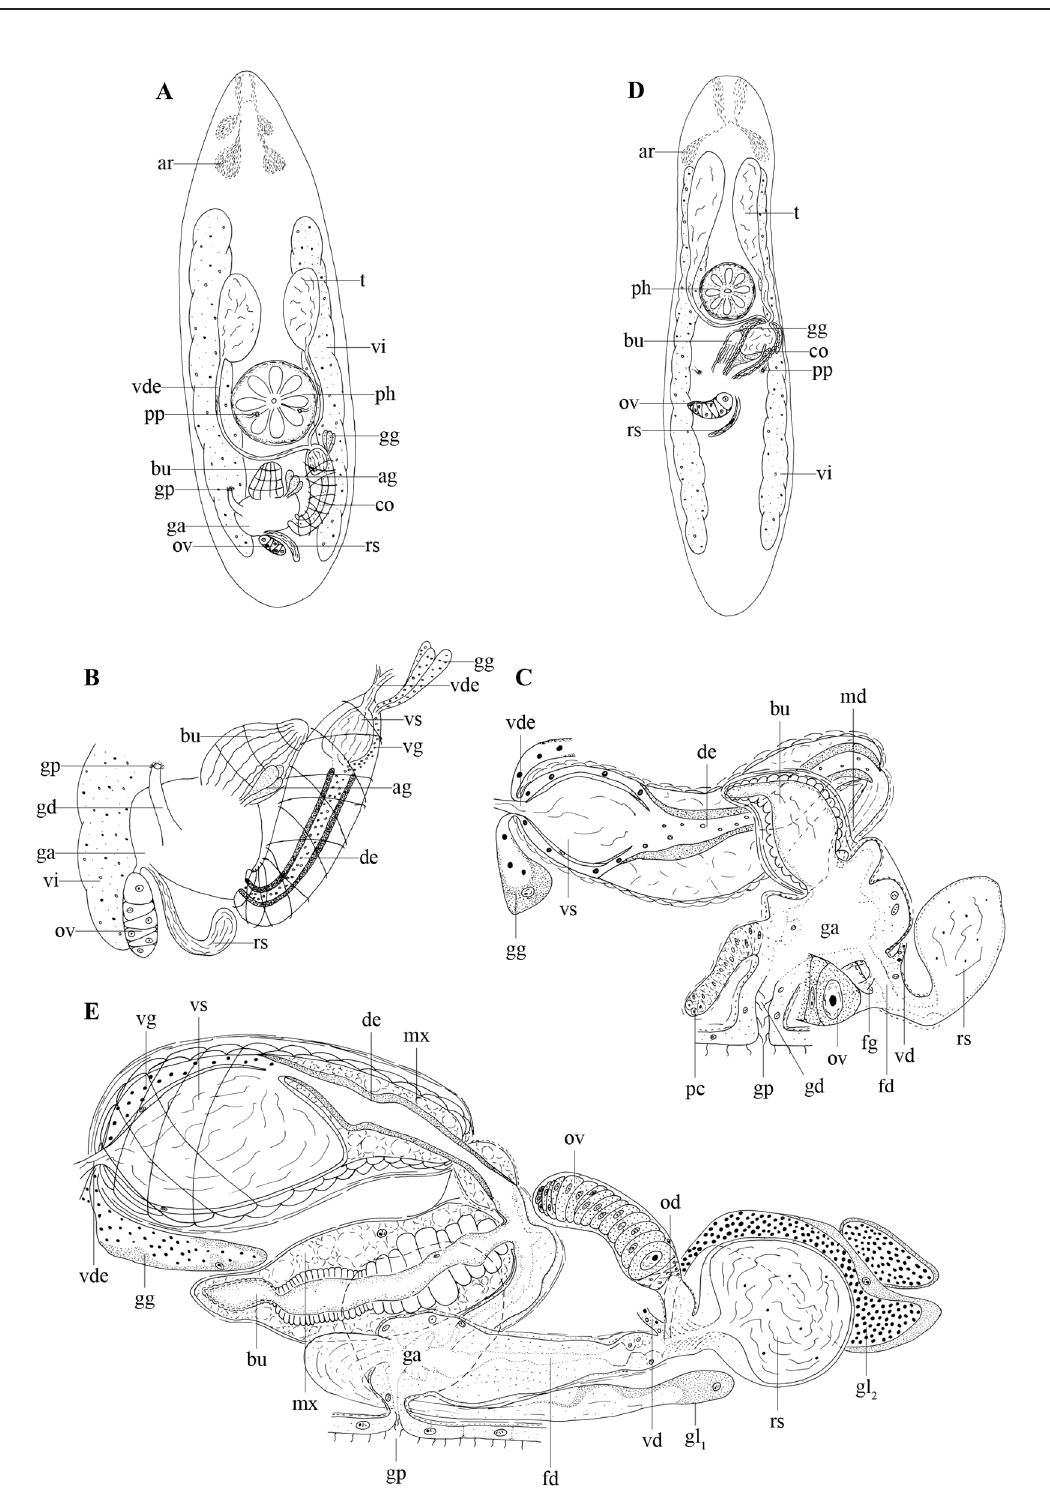
Fig. 8. Two species of Krumbachia Reisinger, 1924. A–C . Krumbachia subterranea Reisinger, 1933. A . Internal organisation of a live specimen. B . Organisation of the genital system of a live specimen. C . Reconstruction of reproductive organs based on sagittal sections of the neotype (neotype no. 823). D–E . Krumbachia virginiana (Kepner & Carter, 1931) Ruebush, 1938. D . Internal organisation of a live specimen. E . Reconstruction of reproductive organs based on sagittal